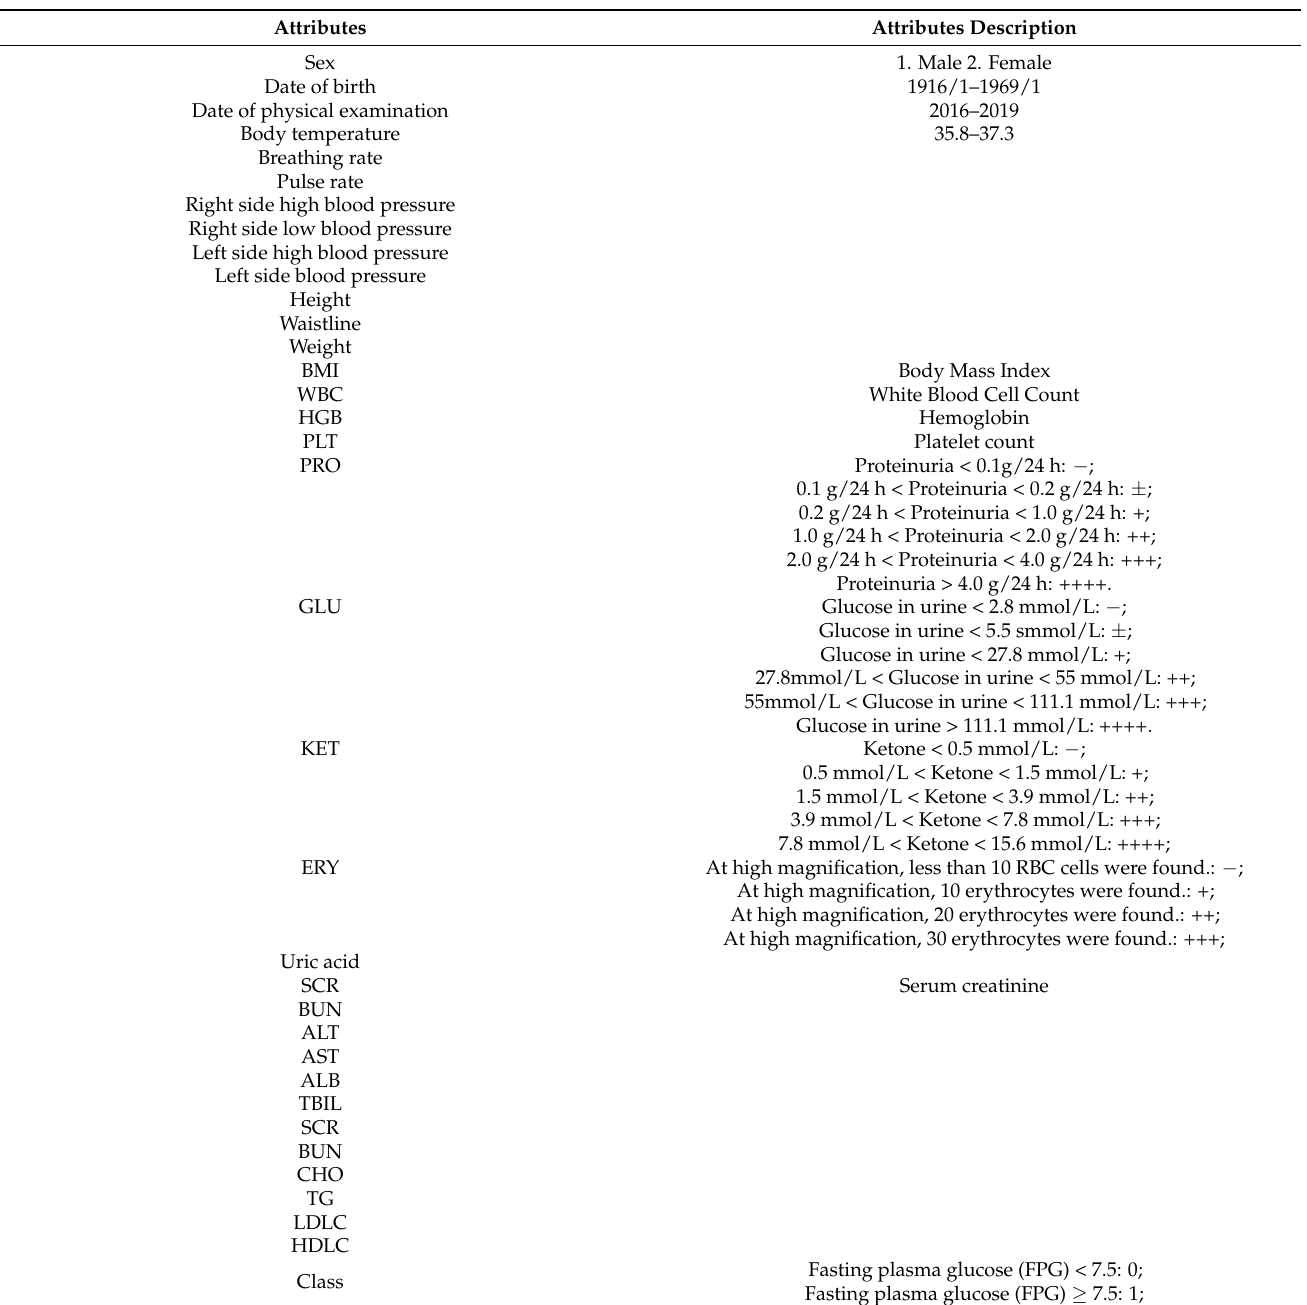
Table A1. Attributes and description of desensitization physical examination data from Qingdao